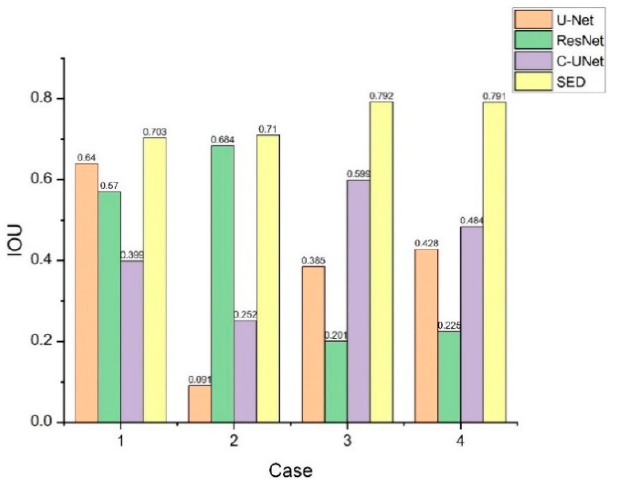
Figure 7. IOU value comparison from four cases by U-Net, ResNet, C-UNet, and the proposed SED.